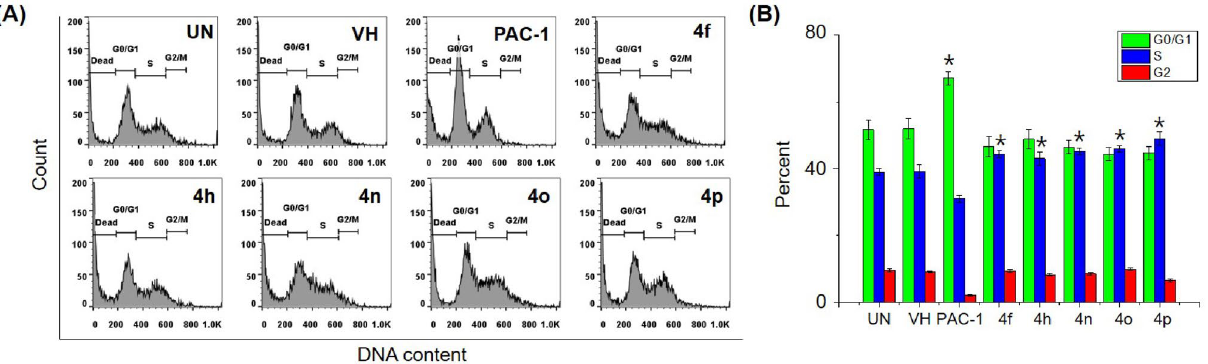
Figure 3. Cell cycle analysis after treatment with some compounds. U937 human lymphoma cells were treated with compounds (50 µM) for 24 h. The harvested cells were stained with propidium iodide (PI) in the presence of RNase and then were analyzed for DNA content by using flow cytometry. Ten thousand cells were acquired (n = 3). UN untreated, VH vehicle (DMSO. 0.1%). Representative histograms ( A ) and bar graphs ( B ) are shown. p values were calculated using one-way ANOVA in GraphPad Software (San Diego, CA, USA). * p < 0.01 vs VH control.